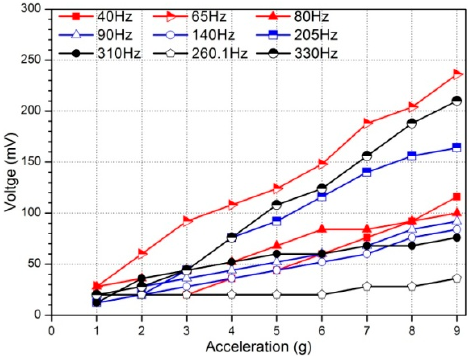
Figure 8. Voltage versus excitation acceleration at nine group